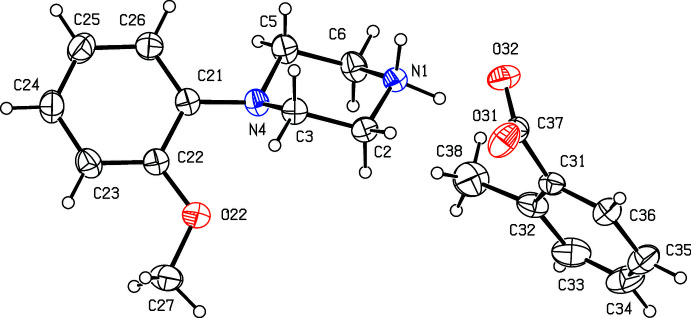
The independent components of compound (VIII) showing the atom-labelling scheme. Displacement ellipsoids are drawn at the 30% probability level.